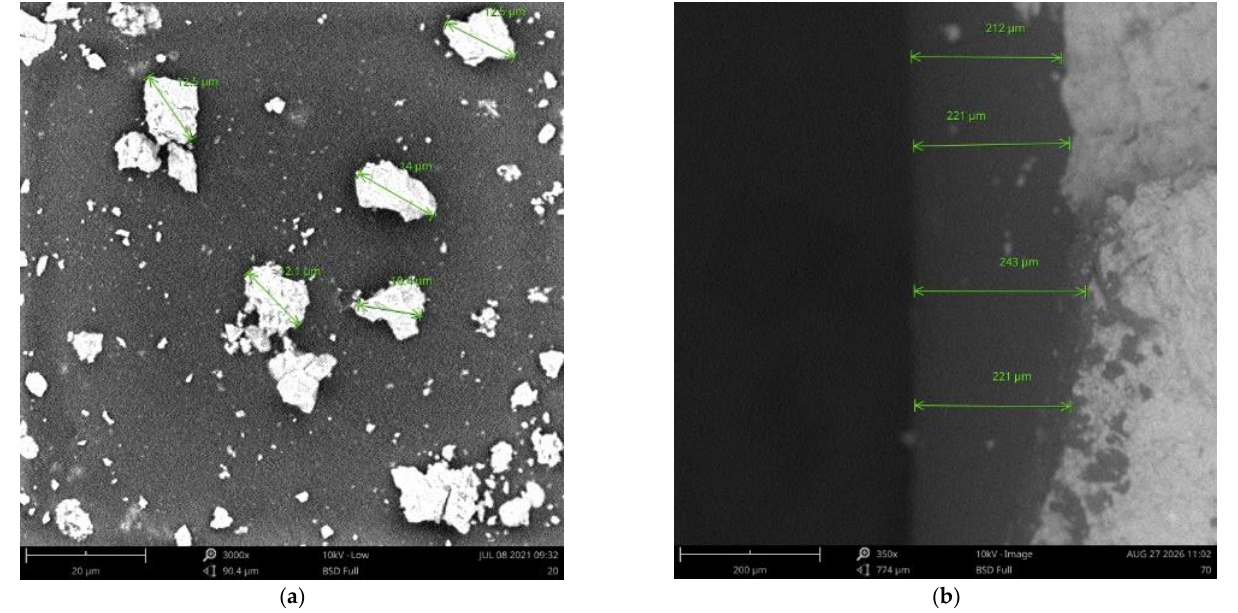
Figure 5. Asphalt mixture images at different magnifications: ( a ) magnified 3000 times; ( b ) magnified 50,000 times.